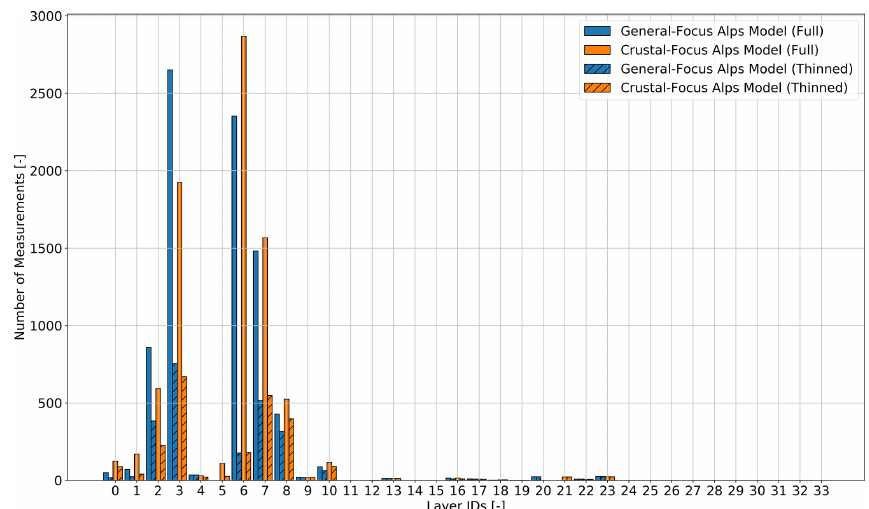
Figure 1. Distribution of the measurements according to the geological layers. For the layer IDs, please refer to Table A1 in the Appendix.